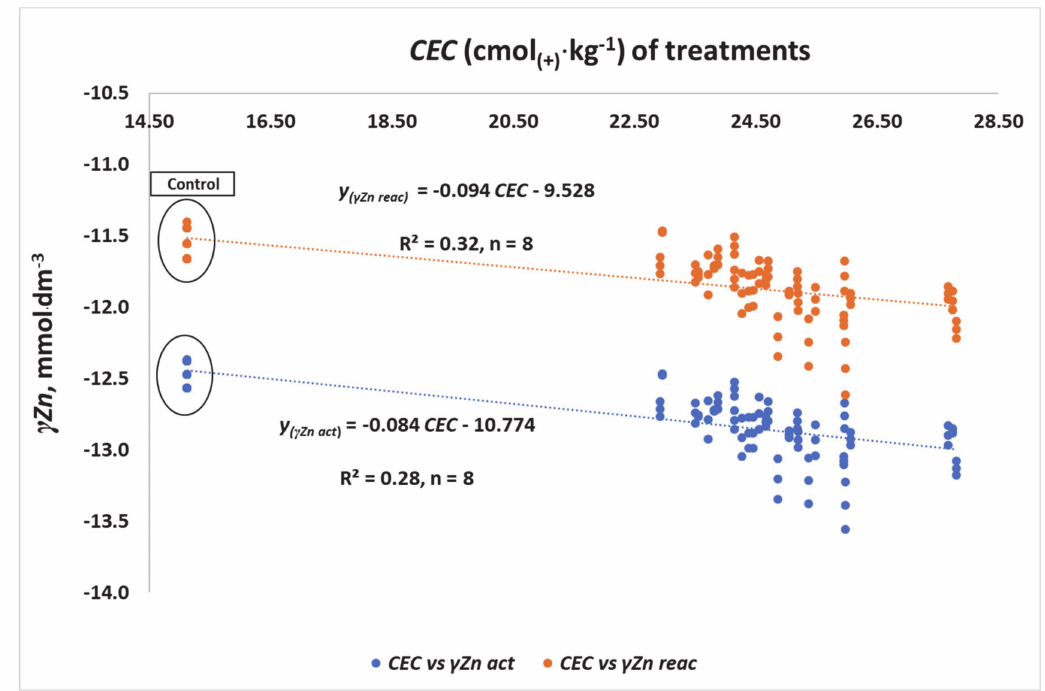
Figure 7. Relationships established for the pairs Zn activities of the active ( Zn act ) and reactive ( Zn reac ) fractions versus CEC of the sorbents treated